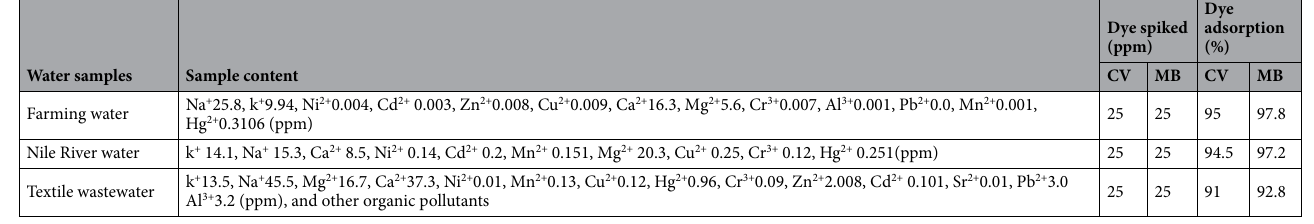
Table 5. Adsorption of MB and CV from real water samples using